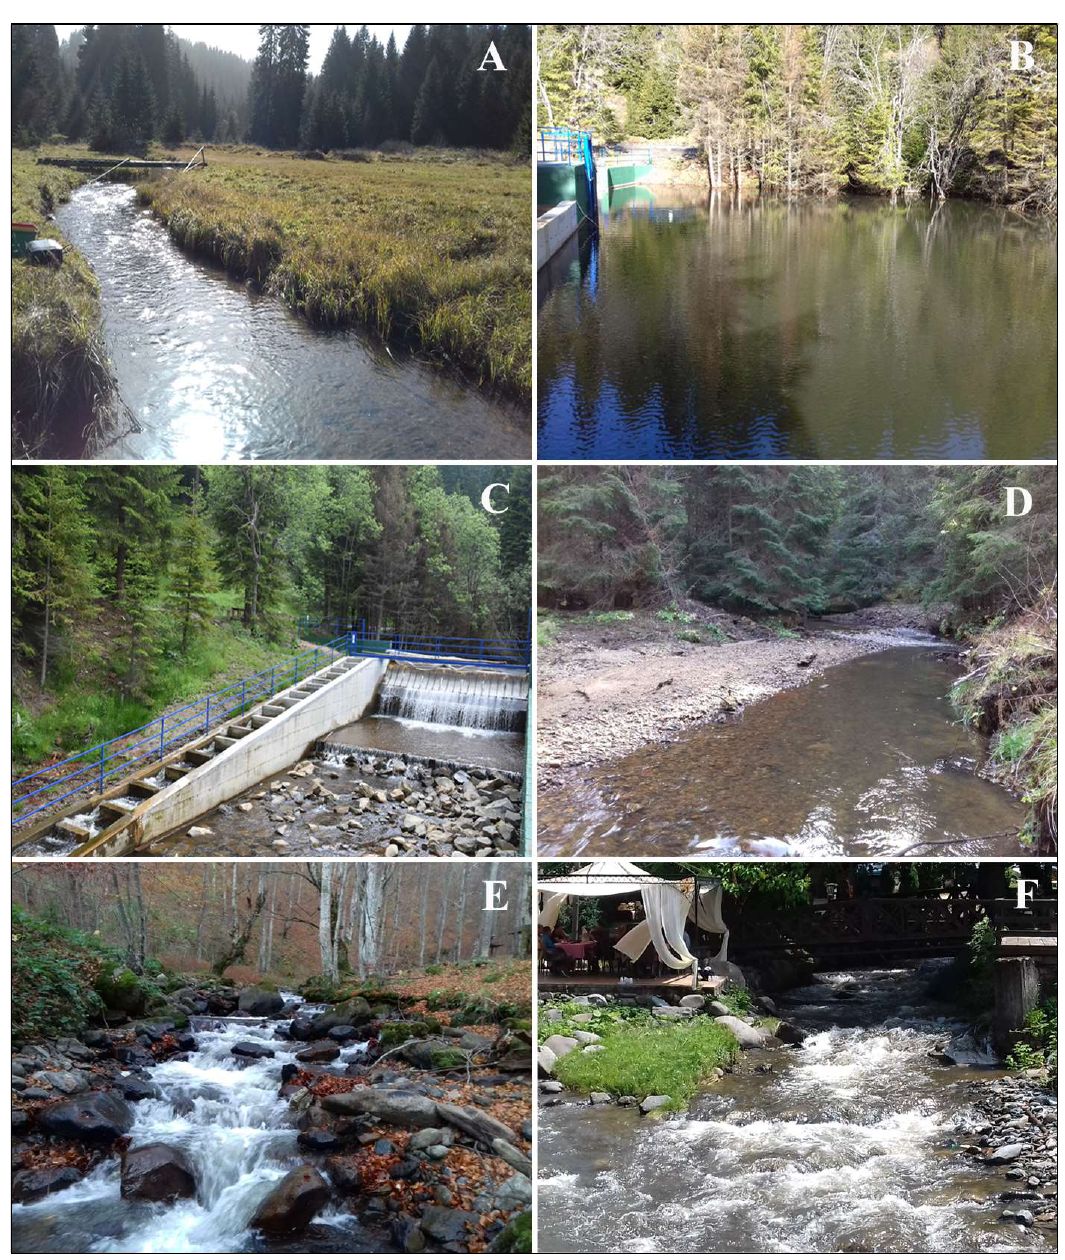
Figure 1. A  locality S1; B  locality S2 (photos by A. Mitrović, 2018); C  dam of the small HPP “Samokovska reka 1” (photo by S. Simić, 2018); D  locality S3; E  locality S4; F  locality S5 (photos by S. Radosavljević,